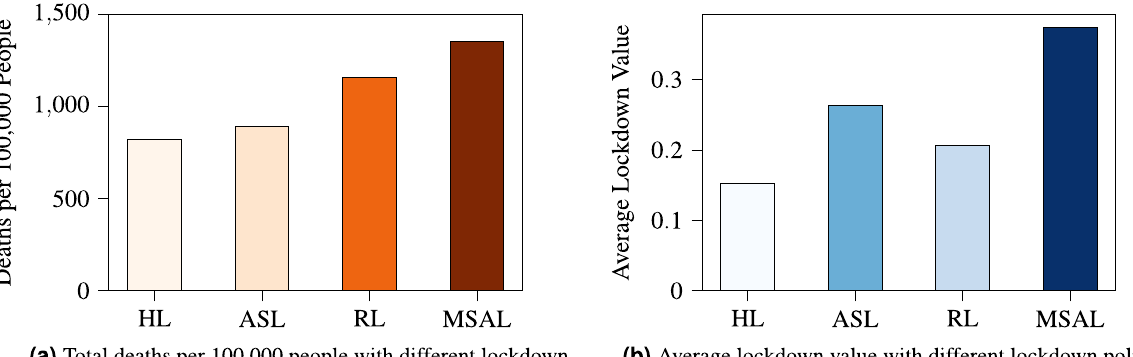
Figure 7. Comparison of the number of deaths and average lockdown values resulting from different classes of lockdown policies. Utilizing the HL policies results in the smallest average lockdown value while also inducing the least number of cumulative